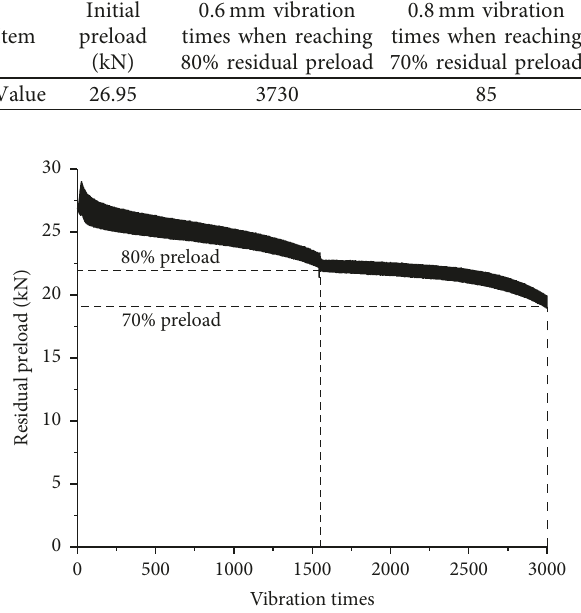
Figure 11: Variable amplitude test loosening curve “from big to small.” Table 7: Variable amplitude test results of “from big to small.”